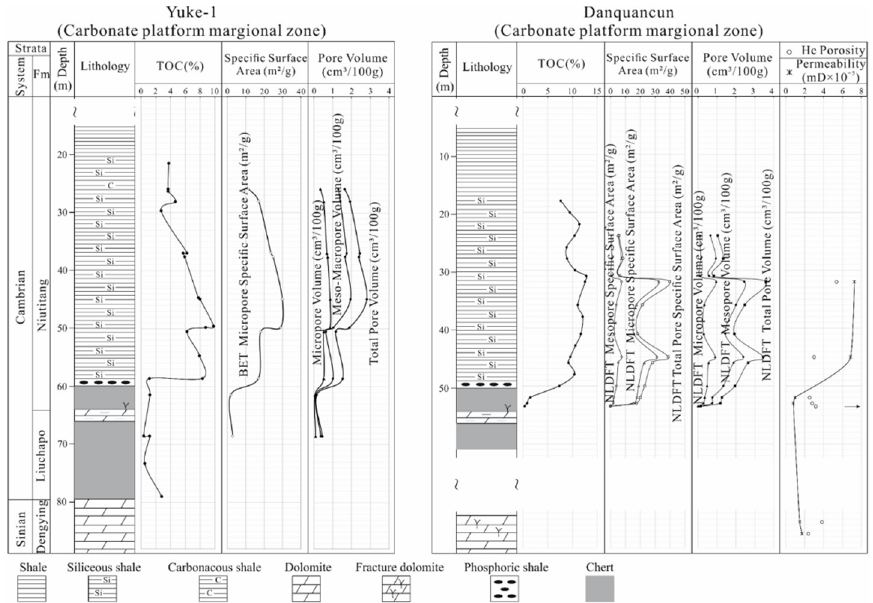
Figure 10. Depth profiles of the total organic carbon (TOC) content, specific surface area, pore volume, He porosity, and permeability of the Niutitang shale in the Yuke-1 well (data from [32]) and TOC, nonlocal density functional theory (NLDFT) specific surface area, NLDFT pore volume, He porosity, and permeability for the Niutitang shale and its floor interval at the Danquancun section. The floor interval with low permeability is thought to be an effective petroleum-resisting layer. The pore volume and specific surface area of the shale interval closing to low permeability floor interval are relatively bigger than the above shale interval with similar TOC. The permeability of the fractured chert sample is beyond the scope of the chart (the arrows). Fm = Formation.